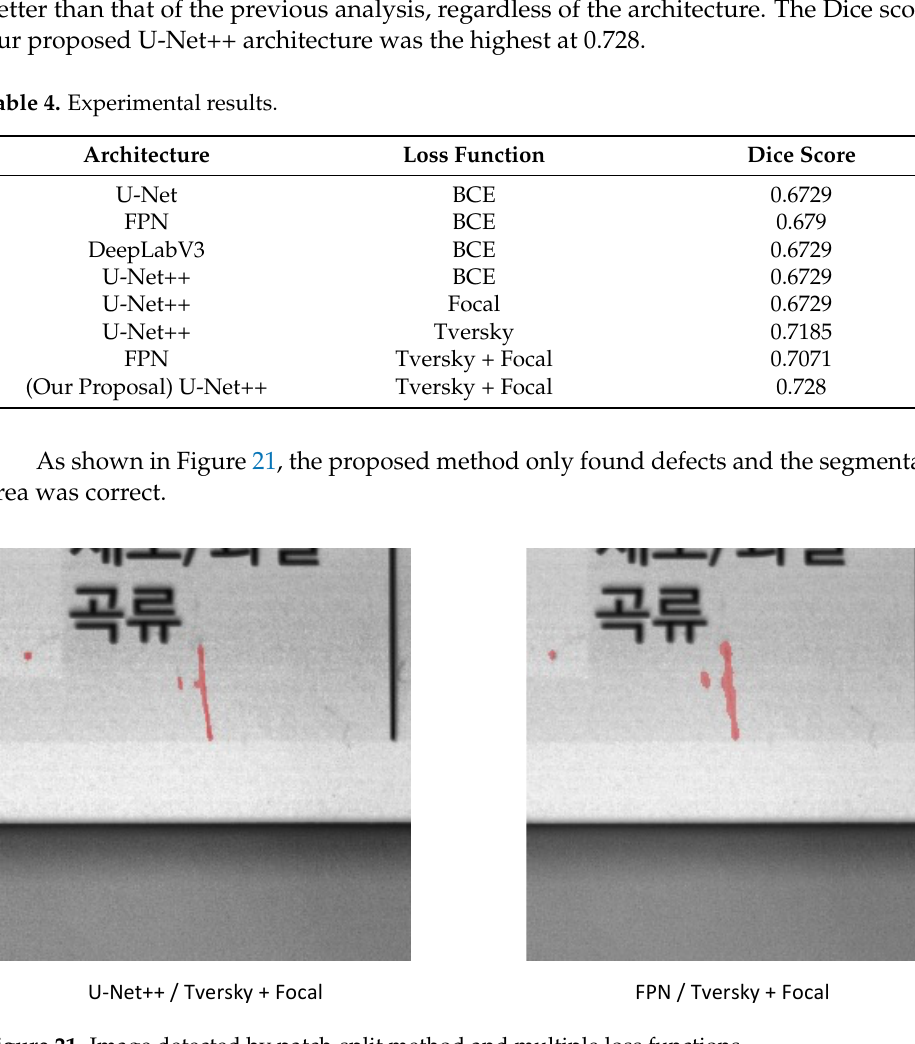
Figure 21. Image detected by patch-split method and multiple loss functions.